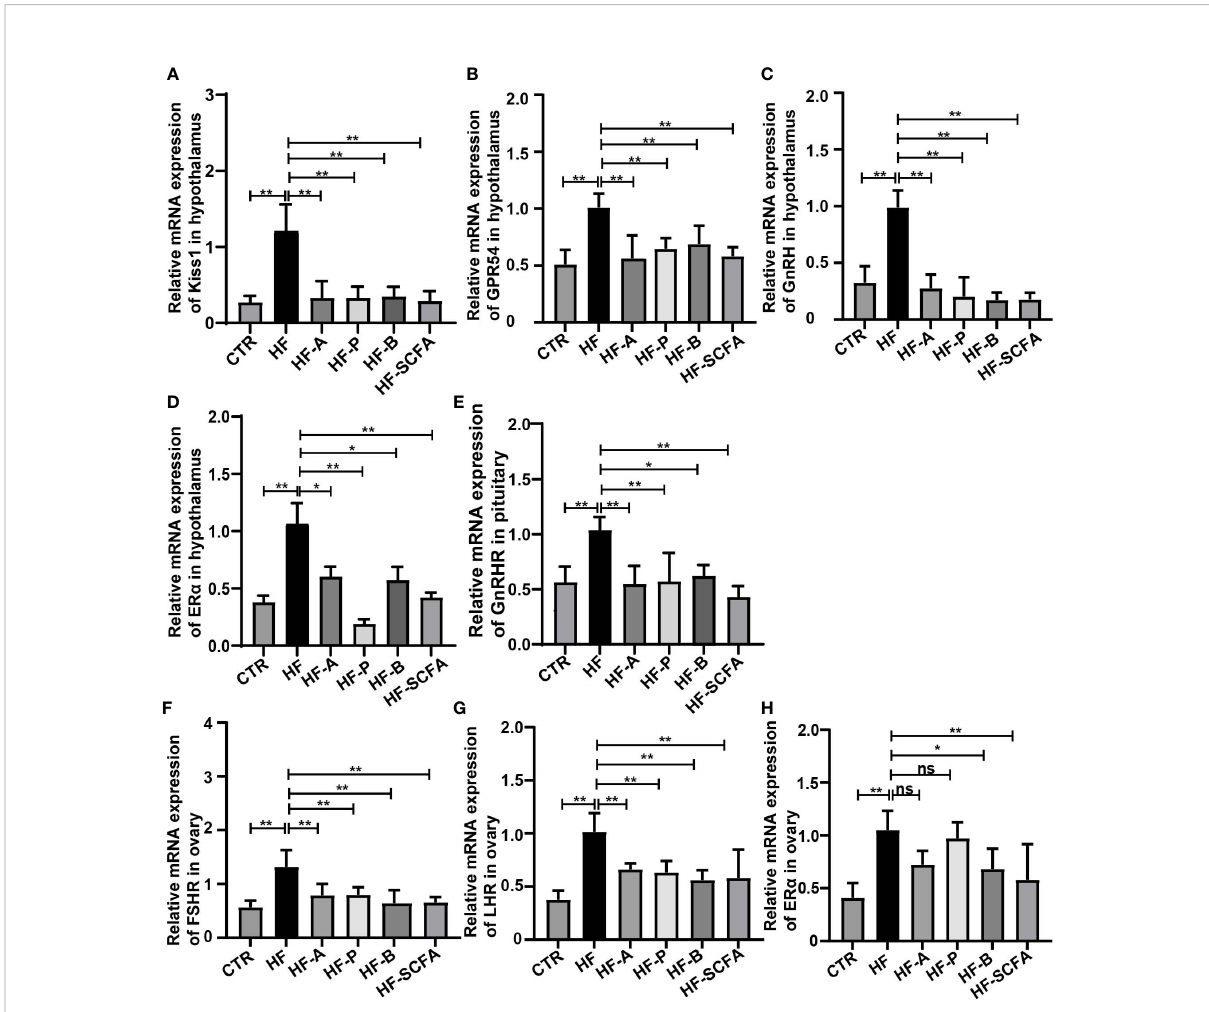
FIGURE 6 SCFAs reverse the expression of genes related to the HPGA in rats with obesity-induced precocious puberty. (A) The gene expression of Kiss1 in the hypothalamus. (B) The gene expression of GPR54 in the hypothalamus. (C) The gene expression of GnRH in the hypothalamus. (D) The gene expression of ER a in the hypothalamus. (E) Gene expression of GnRHR in the pituitary. (F) The gene expression of FSR in the ovary. (G) The gene expression of LHR in the ovary. (H) The gene expression of ER a in the ovary. n = 6 per group for rat samples. * P <0.05; ** P